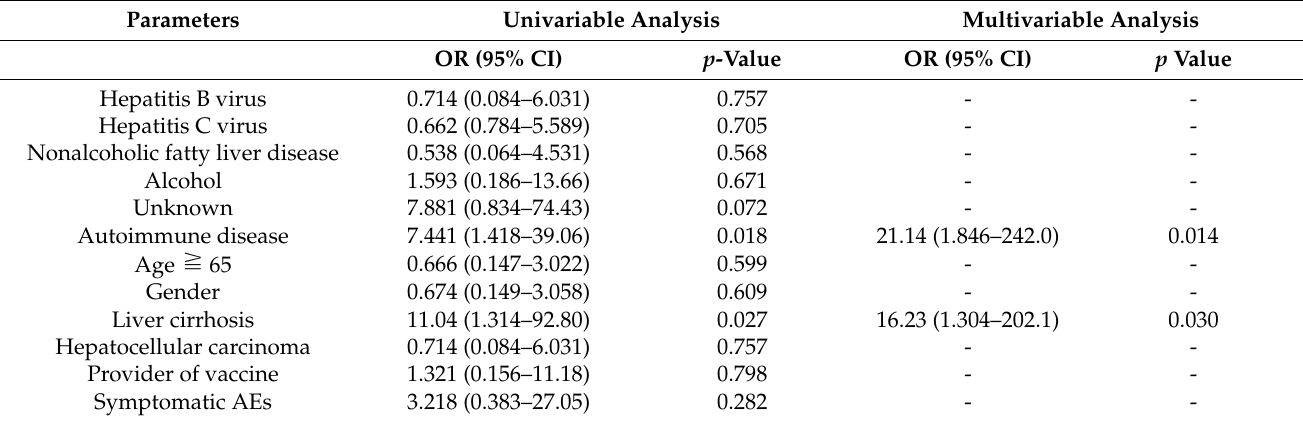
Table 4. Univariable and multivariable analyses for severe LrAEs.